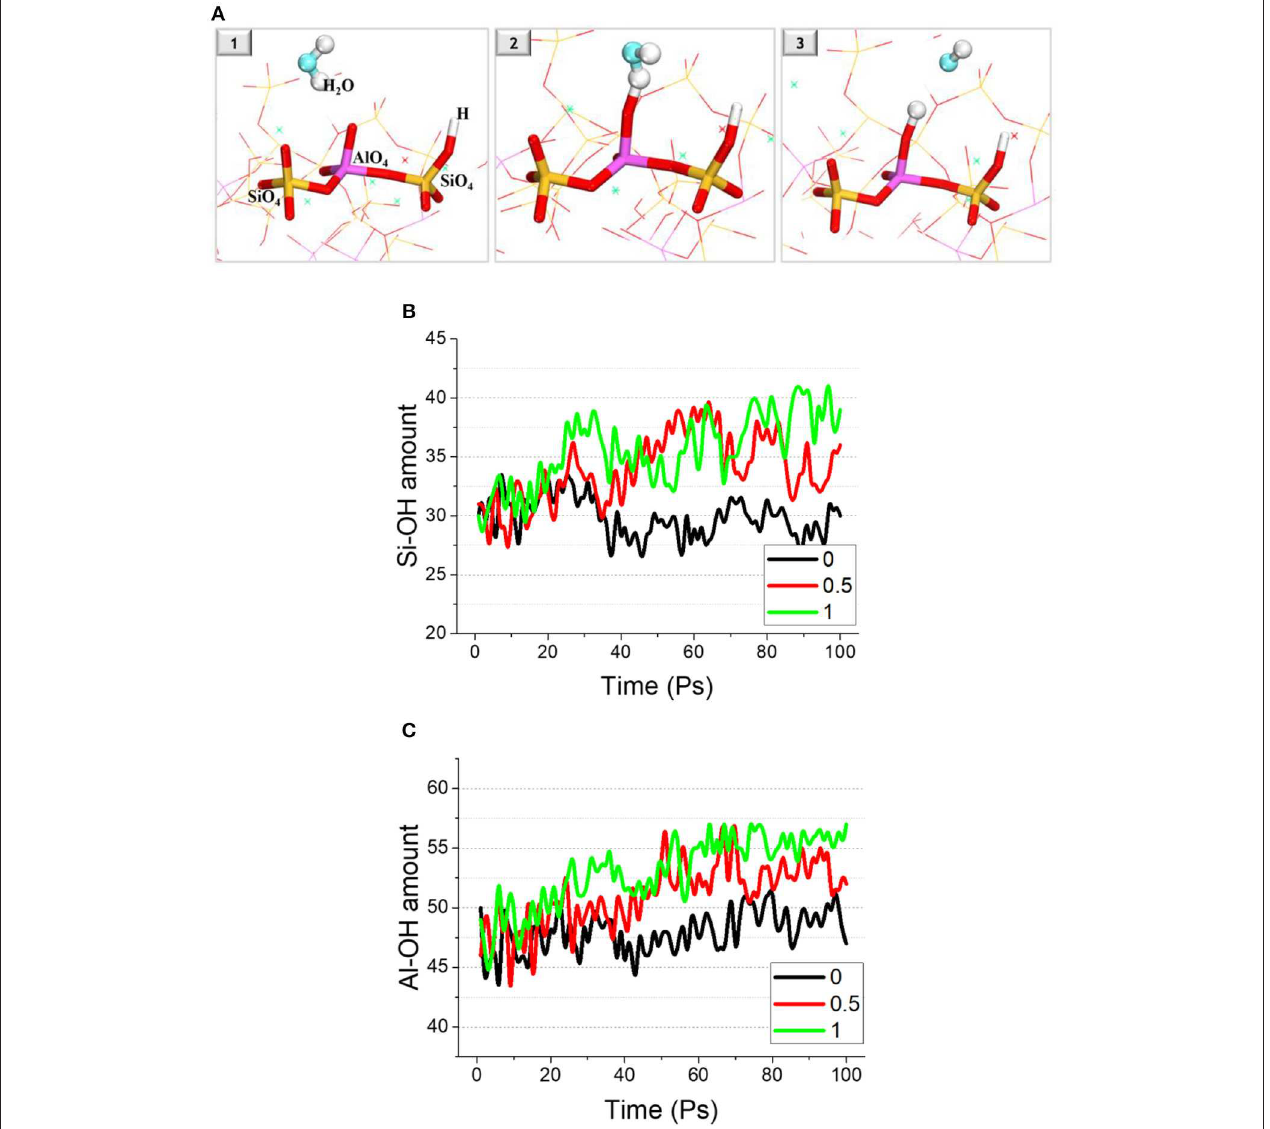
FIGURE 4 | (A) Snapshot of the hydrolysis reaction process, in which yellow-red sticks represent the Si-O bond; purple-red sticks stands for the Al-O bond; red-white sticks are the hydroxyls attached to Si or Al. The amount of (B) Si-O and (C) Al-O bonds as a function of